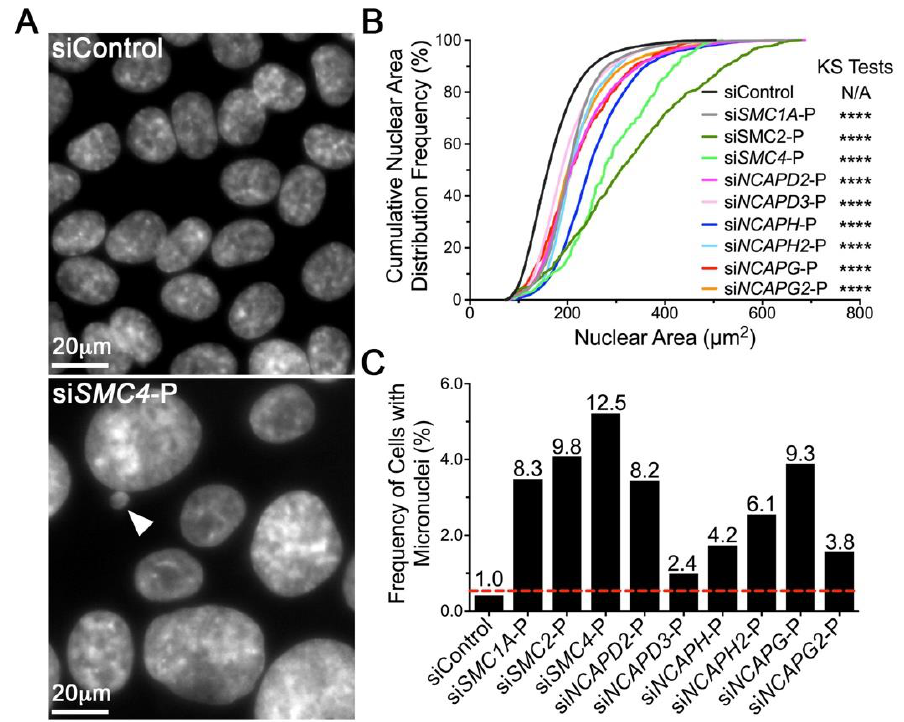
Figure 2. Reduced condensin gene expression induces significant changes in NAs and MN formation in HCT116. ( A ) Representative micrographs depicting visual differences in NAs and MN formation (arrowhead) following condensin gene silencing using siRNA pools (-P) relative to siControl. Note the scale bars are identical. ( B ) Cumulative NA distribution frequencies following condensin gene silencing relative to siControl (black). Kolmogorov-Smirnov (KS) tests reveal statistically significant increases in NA distributions (rightward shift) following silencing relative to siControl (N / A, not applicable; ****, p < 0.0001). ( C ) Column graph presenting the mean frequency of cells with micronuclei following silencing, with the mean fold increase (relative to siControl) indicated above each column. The red dashed line identifies the minimum threshold (mean + 2 standard deviations of siControl) required to be considered a significant increase in MN